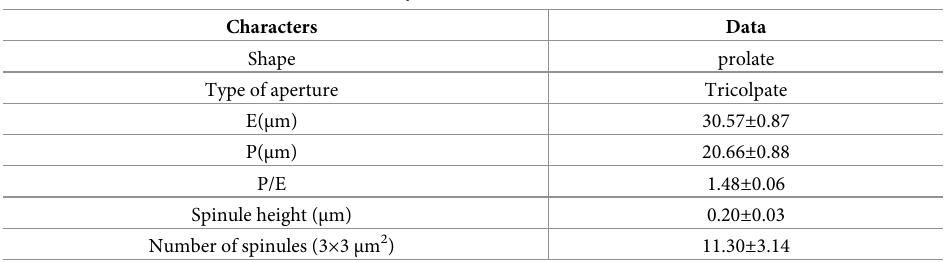
Table 1. Pollen characteristics of Clematis serratifolia